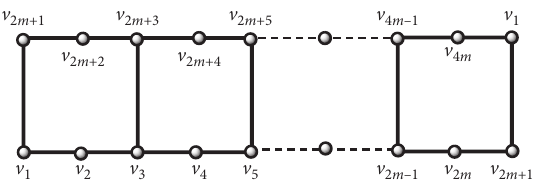
Figure 4: Hexagonal M¨obius ladder graph HML